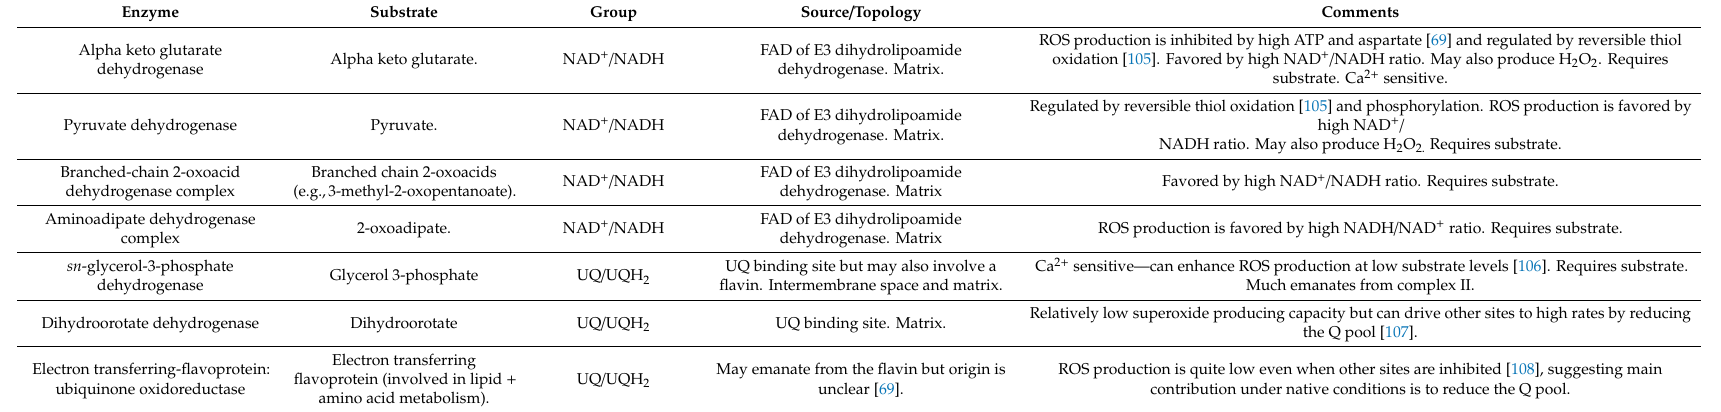
Table 1. Additional sites of superoxide production in mitochondria by enzyme, substrate, iso-potential group, source and topology. Commentary is provided as